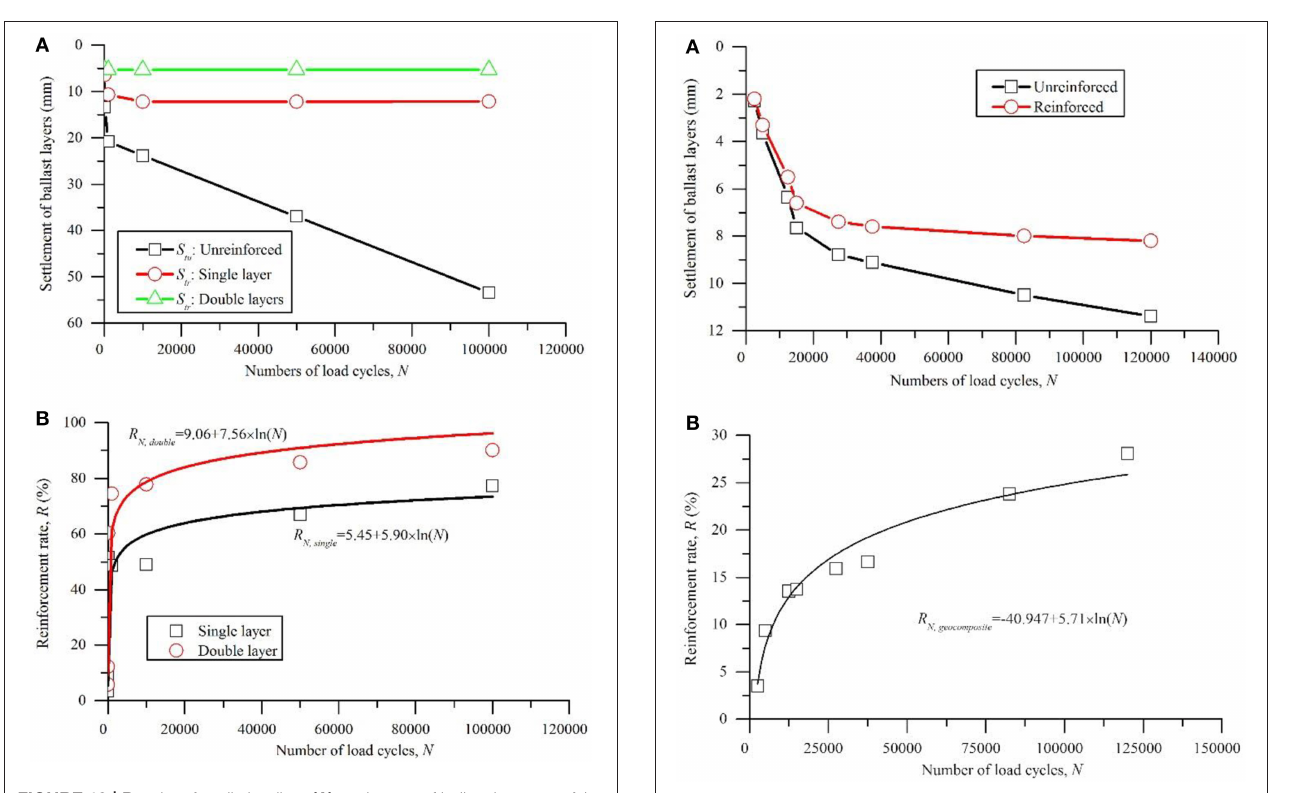
near Bulli, NSW, Australia (modified after Indraratna et al., 2010): (A) settlement of the ballast layers with and without geocomposite reinforcement; (B) reinforcement rate of